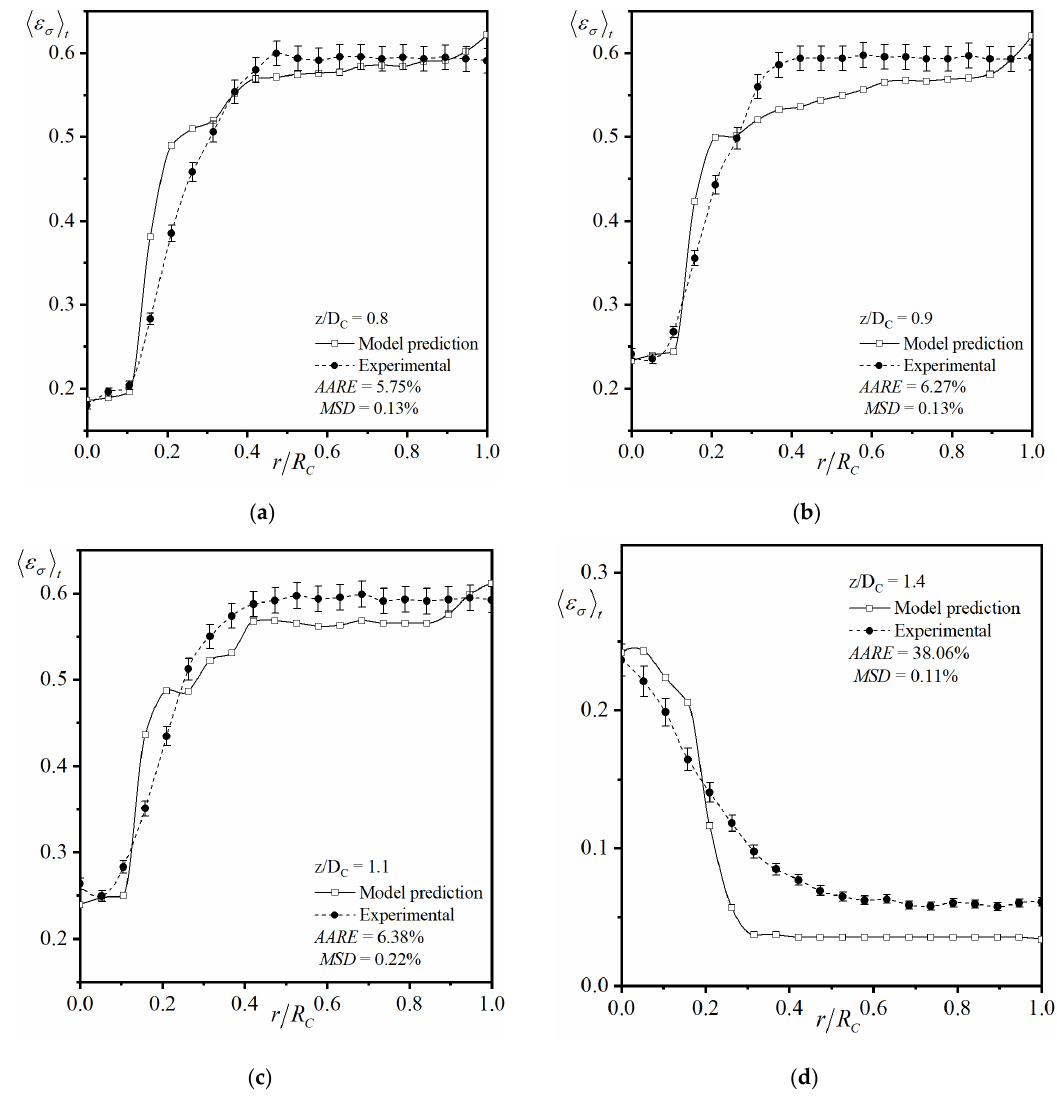
Figure 8. Experimental and model predicted time-averaged radial solids holdup distribution for a spouted bed packed with 2 mm glass beads, H σ ,0 = 160 mm and ( b ) z / D C = 0.9 ( c ) z / D C = 1.1 ( d ) z / D C =